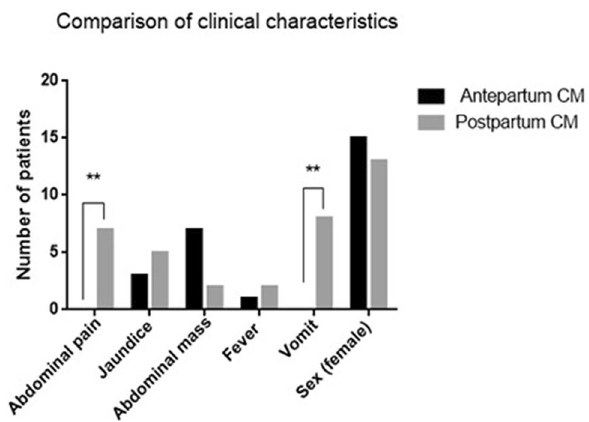
Figure 2. Comparison of clinical characteristics between prepartum-diagnosed CM and postpartum-diagnosed